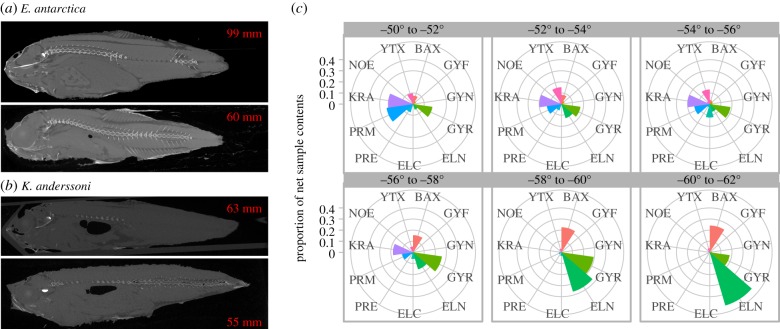
Single slice computed tomography scans of (a) Electrona antarctica showing loss of swimbladder gas and (b) Krefftichthys anderssoni showing gas presence (dark regions in tissue). Fish standard lengths shown in mm. (c) Polar plots of standardized proportions of species captured in 2° latitude bins, each colour segment proportionally corresponds to the abundance of individual species. (Online version in colour.)